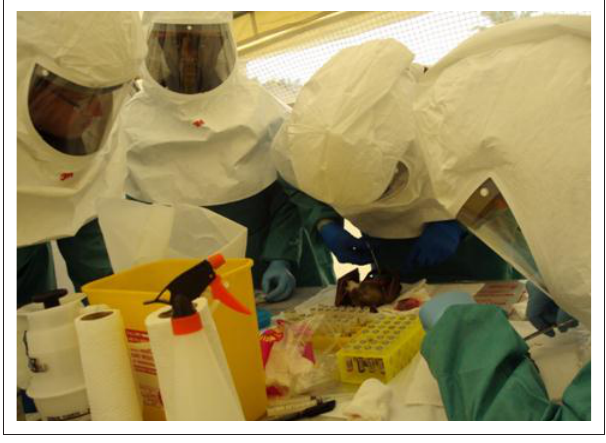
FIGURE 1: The Ebola ecology expedition team arriving in Luebo, Democratic Republic of the Congo, May 2011.